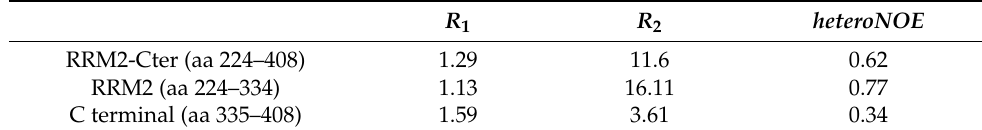
Table 1. Average values of R 1 , R 2 and heteroNOE parameters of different parts of RRM2-Cter (La 224–408).